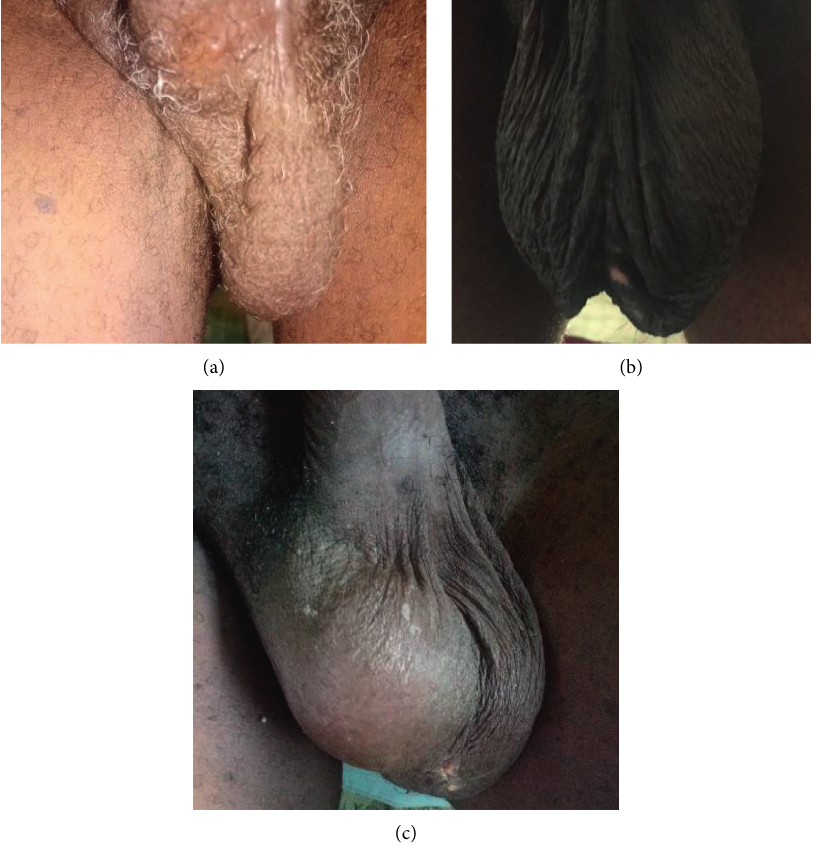
Figure 7: Initial postoperative photographs of patients who had (a) BSO, (b) BSCO, and (c)